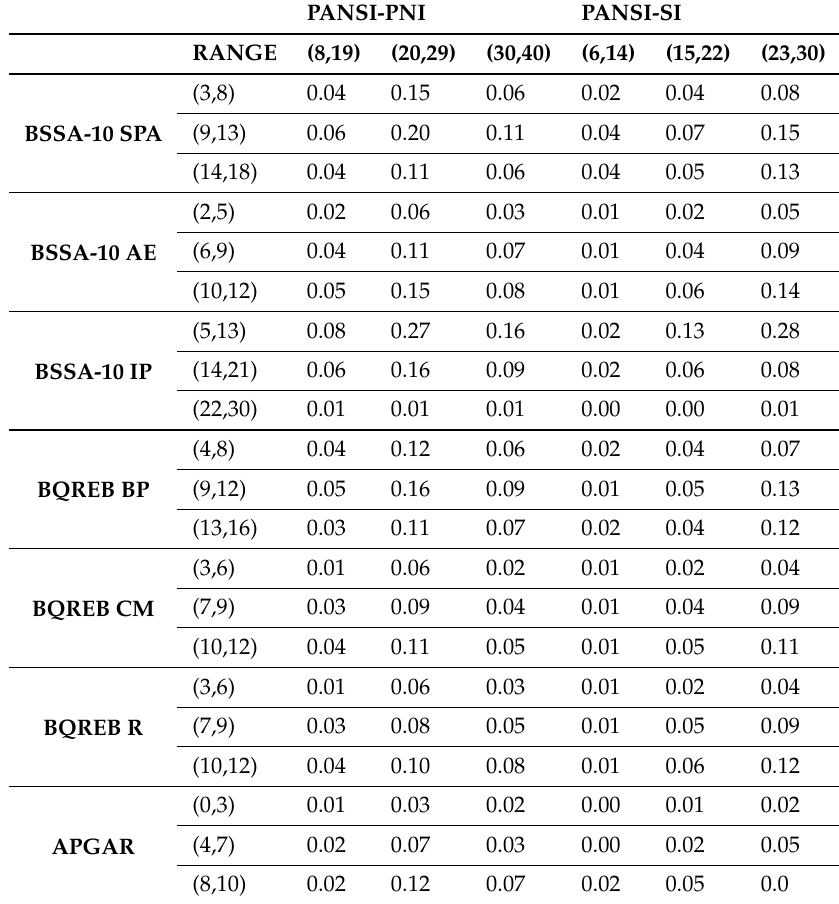
Table 4. Probabilities of developing suicide ideation as a consequnce of different factors from instruments BSSA-10, BQREB, and